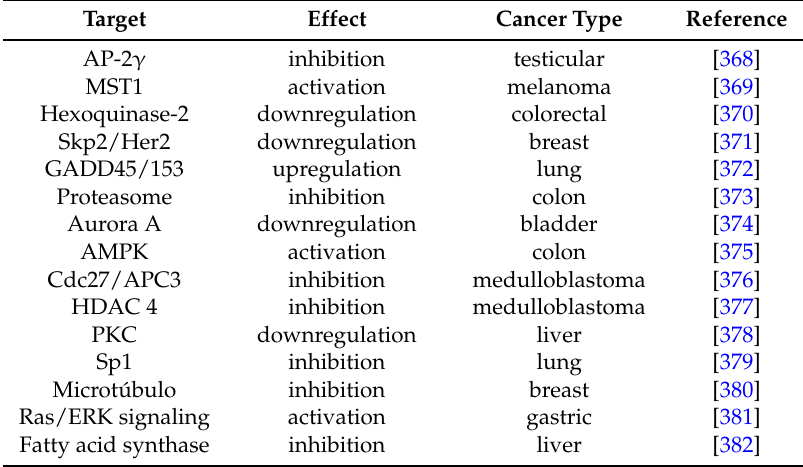
Table 4. Others apoptotic targets for curcumin.